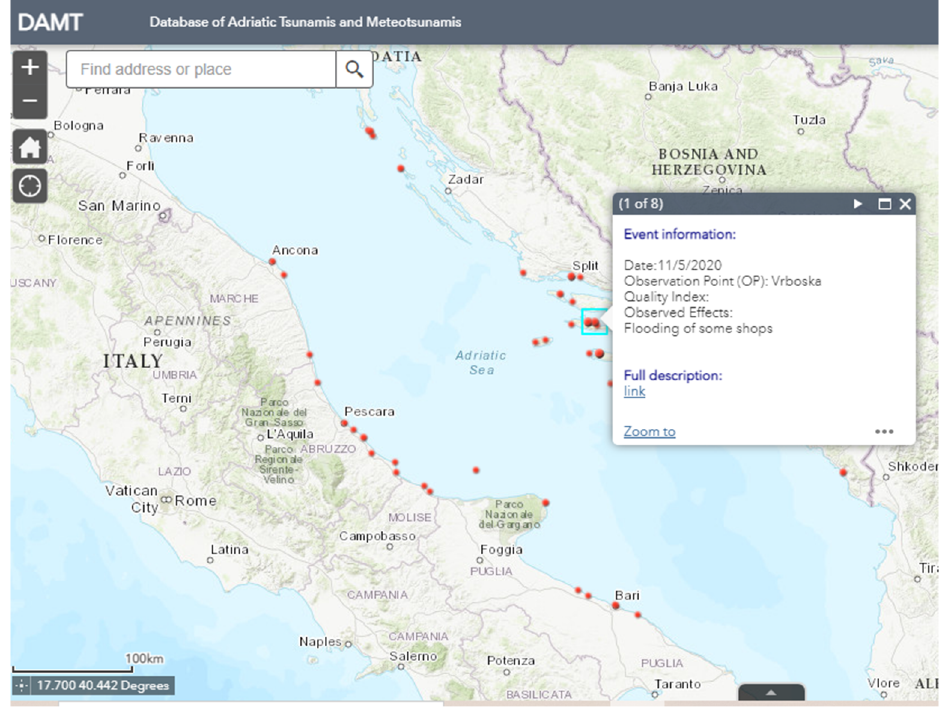
Figure 6. Example of a pop-up of the AM layer, showing the 15 May 2020 at Vrboska observation point. By clicking on the full description link, the user can retrieve detailed information on all effects observed at that location over time.